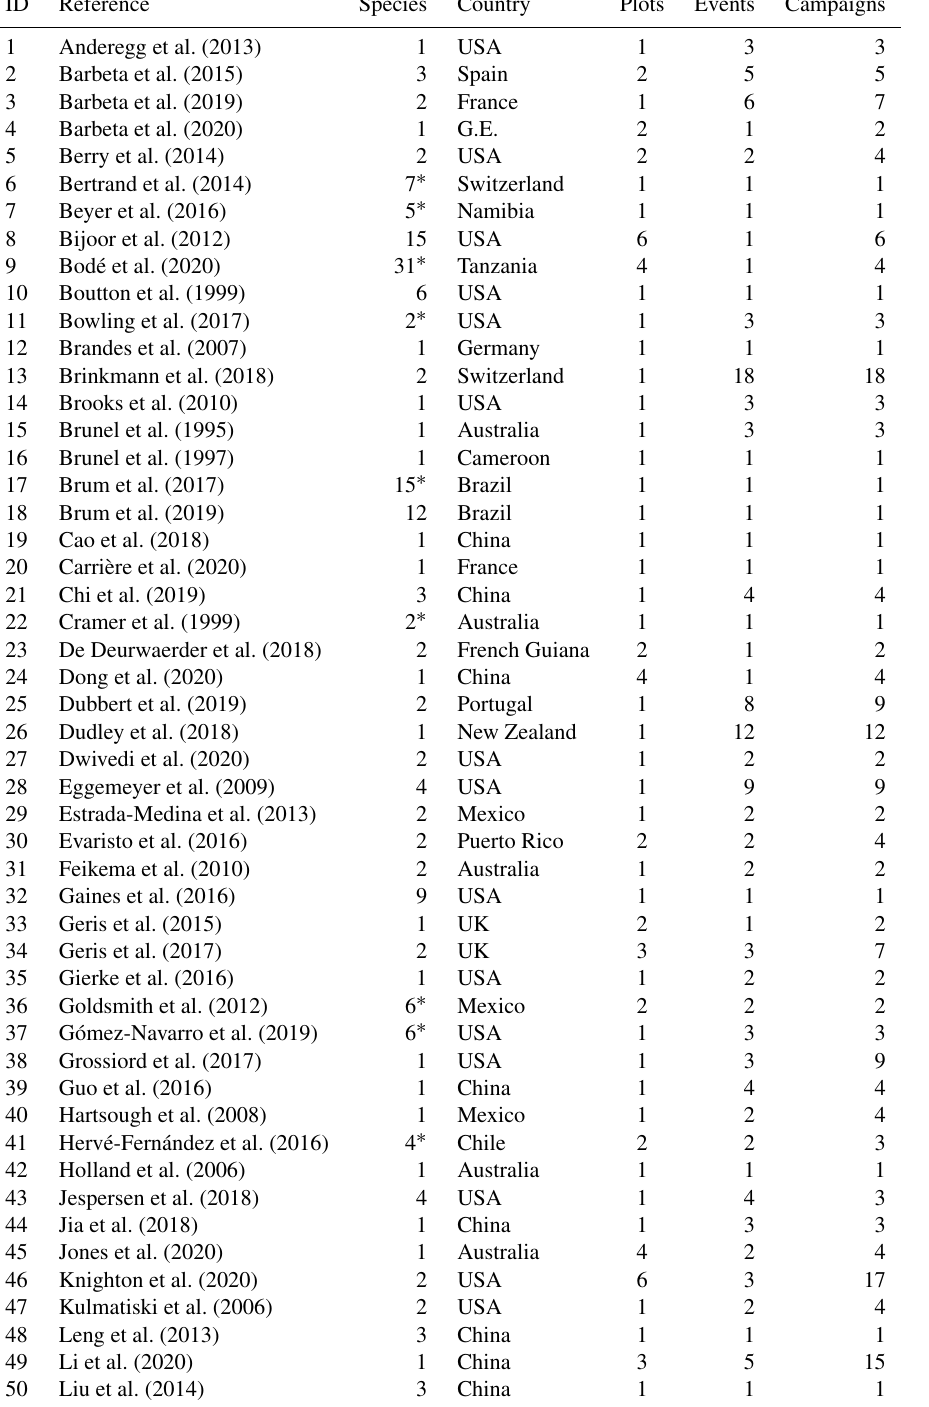
Table 1. List of studies with the number of campaigns for which SW-excess and LC-excess were calculated with the number of plant species sampled, country where the study plots were located (G.E. indicates the glasshouse experiment), number of sampling plots, number of sampling events, and number of campaigns. Asterisks ( ∗ ) next to the number of species indicate that although several species were sampled within a study, it was not possible to ascribe distinct water isotopic compositions to each